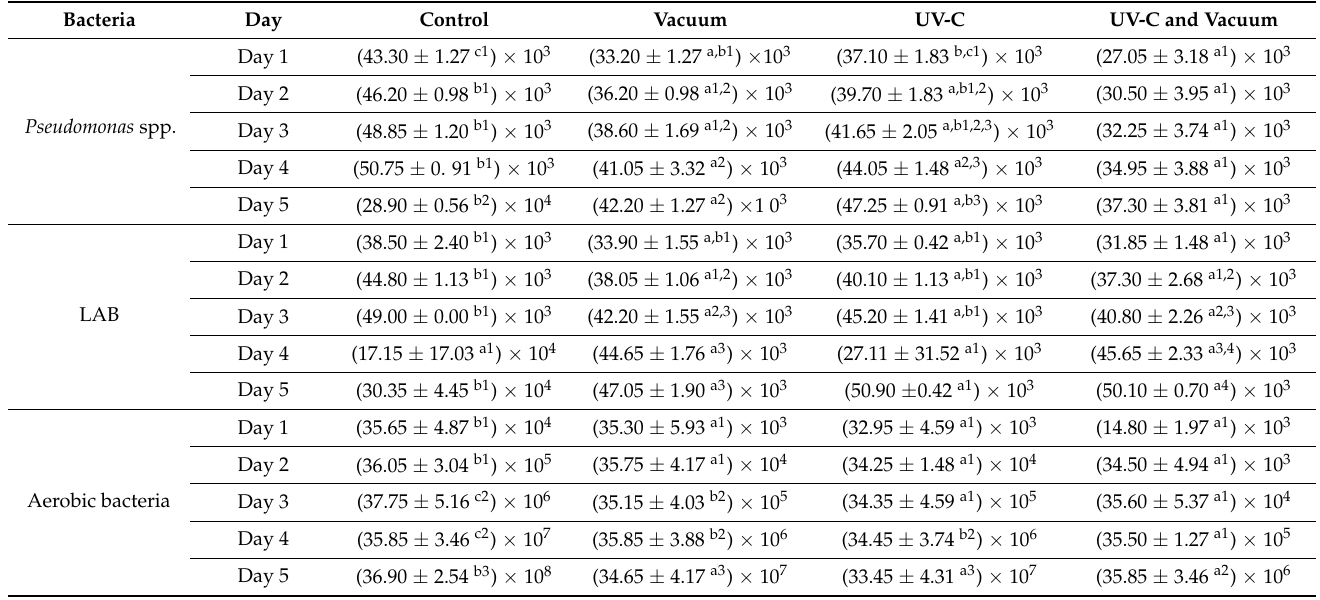
Table 2. The results of the one-way ANOVA analysis and Tukey HSD results, with the mean microbial counts (CFU/g) of the chicken samples.